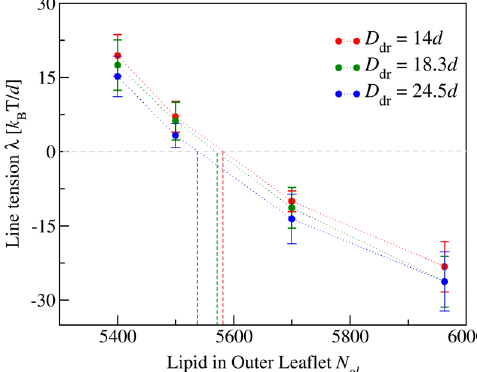
Fig.7 |Linetension λ ofcontactlinebetweendroplet andvesiclemembraneas a function of lipid number N ol for three different droplet sizes D dr , calculated via the force balance relationship in Eq. (12). As we increase N ol , which encodes thetransbilayerasymmetry,thelinetensionundergoesatransitionfrompositiveto negative values. The line tension is positive for N ol =5400 and 5500, for which the whole engulfment process remains axisymmetric and leads to neck cleavage and membrane fi ssion.Ontheotherhand,for N ol =5700and5963,thelinetensionhasa negative value and leads to the formation of a tight-lipped membrane neck as in Fig. 4 which prevents the fi ssion process. The dashed vertical lines provide esti- which lead to λ =0 for the different droplet mates for the lipid numbers N ol = N ½ 0 (cid:2) ol , whichdepend on the dropletsize,aregiven sizes D dr . The numericalvalues of N ½ 0 (cid:2) ol in the last column of Table 1. Each red, green, and blue data point represents the mean value over n =15 statistically independent samples obtained from three replicated simulations. Each error bar is the